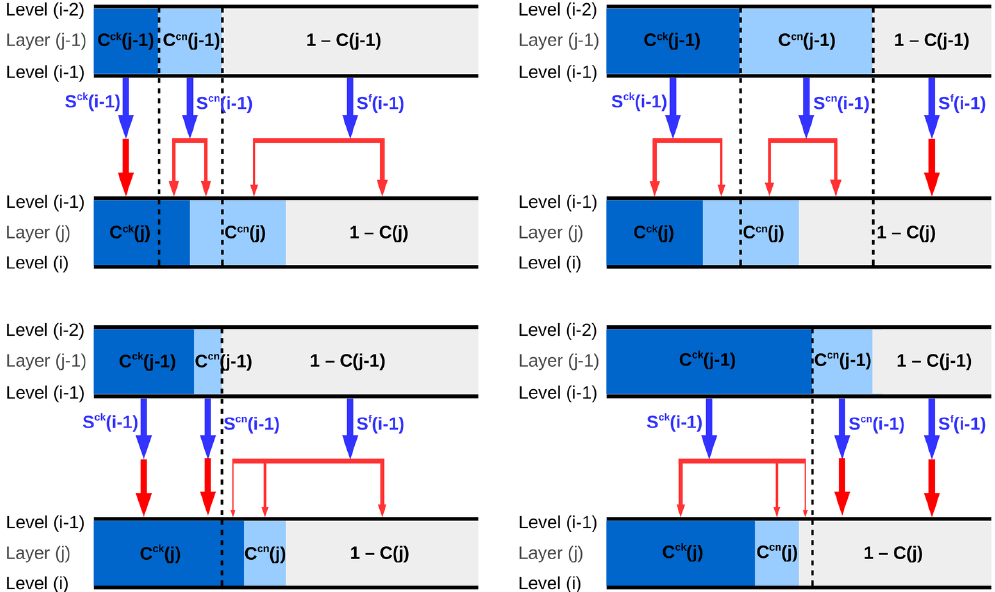
Figure 8. Transmission of direct solar radiation through two adjacent layers with partial cloudiness for the maximum 2 -random overlap